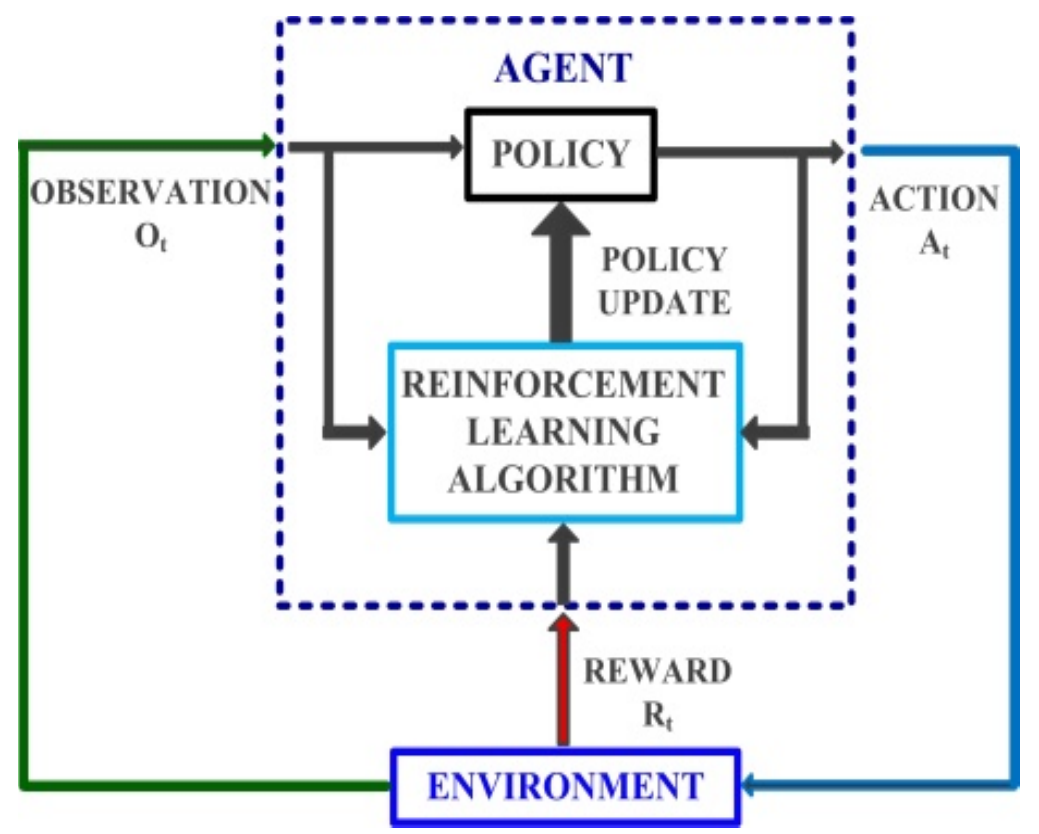
Figure 2. Block diagram of an RL scenario for use in the process control.